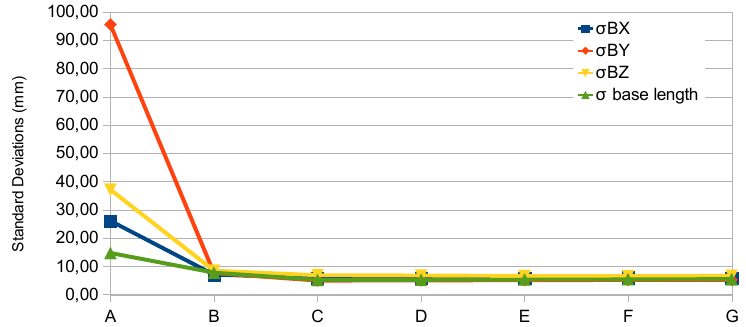
Figure 6. Standard deviations of the computed base components.